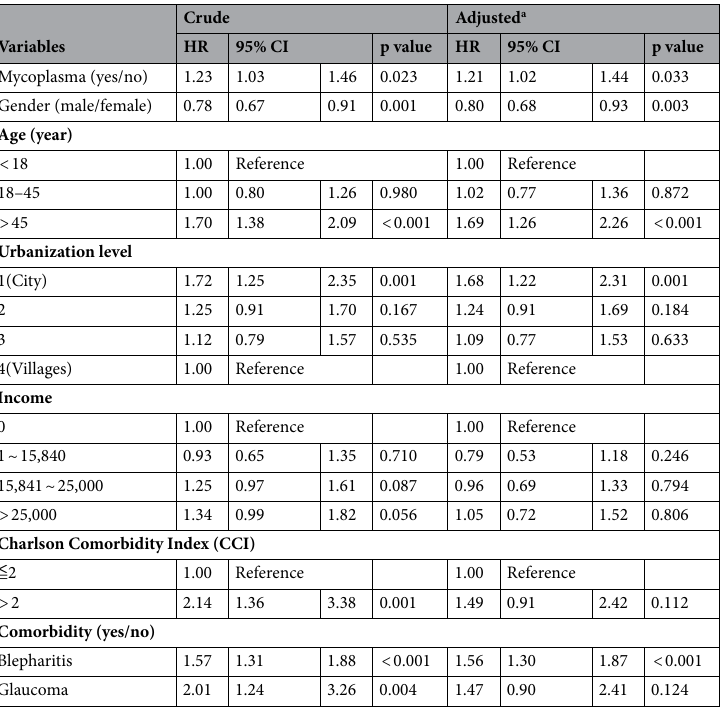
Table 2. Cox model with the hazard ratio (HR) and 95% confidence interval (CI) of corneal and ocular surface infection with potential covariates. Crude HR: relative hazard ratio; Adjusted HR: adjusted hazard ration, mutually adjusted for age, sex, levels of income and urbanizations, Charlson Comorbidity Index scores, and comorbidities of blepharitis and glaucoma.